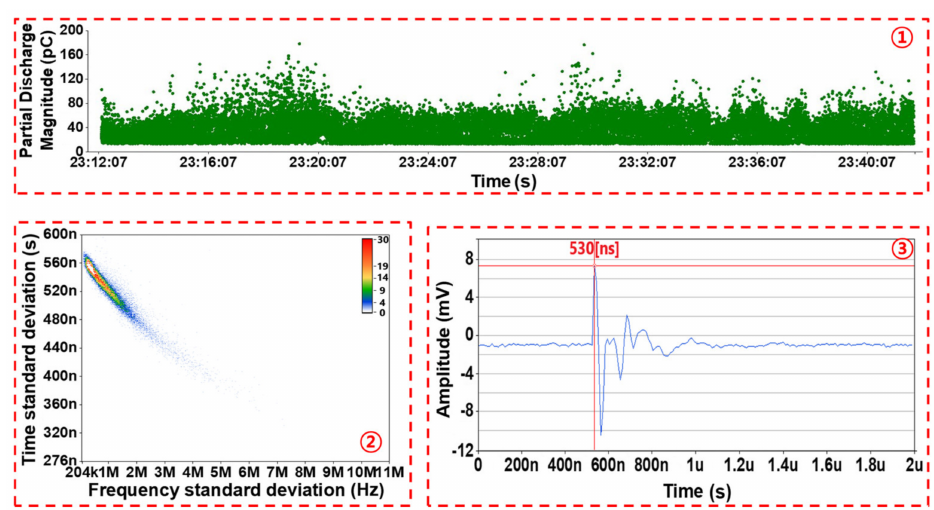
Figure 5. DC partial discharge measurement result using a partial discharge measurement sys- tem